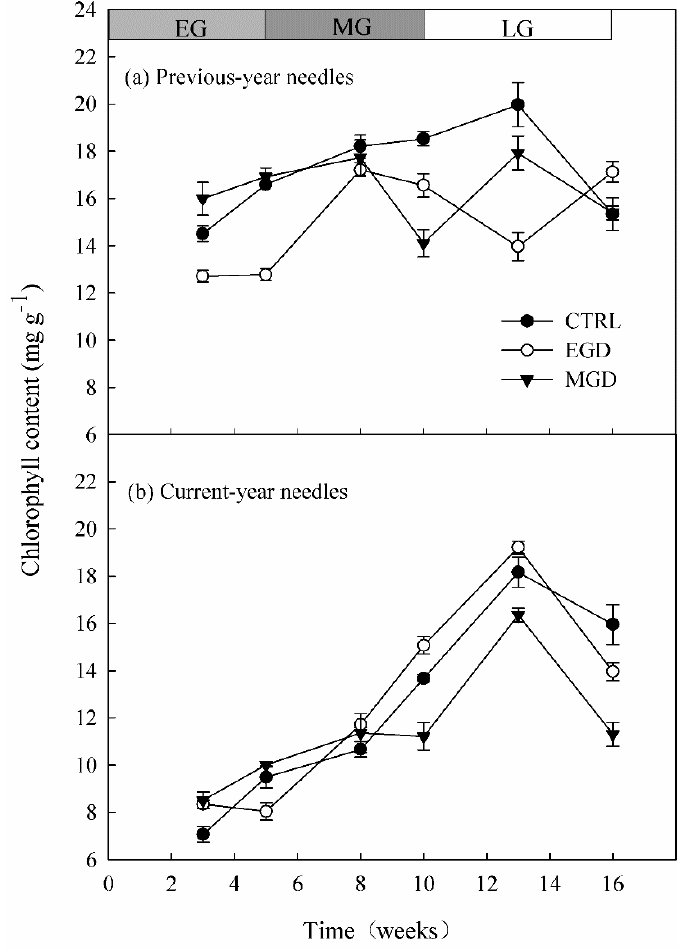
Figure 2. Chlorophyll content in the previous-year ( a ) and current-year ( b ) needles of Mongolian pine saplings by treatment. CTRL indicates the control. EGD and MGD indicate drought stress treatment in the early- (EG) and mid- (MG) growing seasons. EG, MG and LG refer to the early- (weeks 1–5), mid- (weeks 6–10) and late- (weeks 11 − 16) growing season, respectively. Time indicates weeks from the beginning of the experiment. Bars indicate standard error ( n = 4).